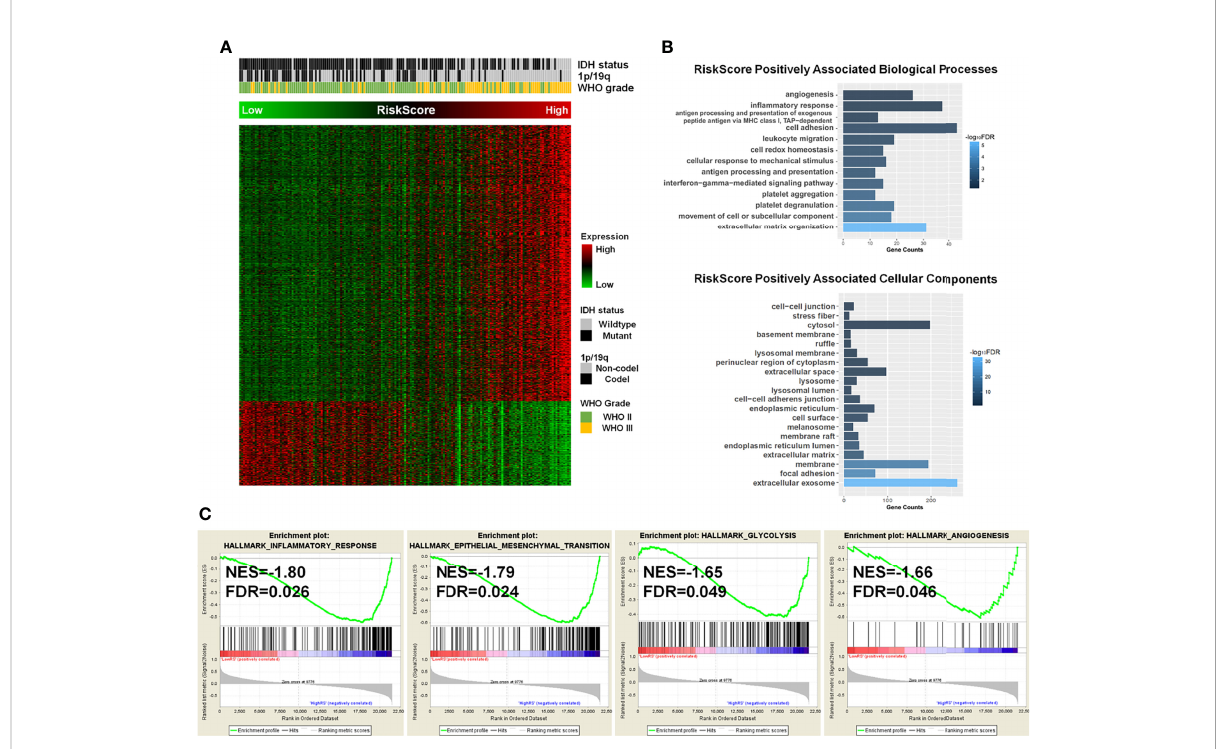
FIGURE 4 The potential molecular alterations of high-risk LGG patients. (A) Associations between the enzyme-based risk value and the clinicopathological features and its related genes. (B) Gene Ontology analysis of biological processes and cellular components for high-risk positively associated genes. (C) Gene set enrichment analysis revealed that the hallmark gene sets of cancer, including in fl ammatory response, epithelial – mesenchymal transition, glycolysis, and angiogenesis, were signi fi cantly enriched in high-risk groups. LGG, lower-grade